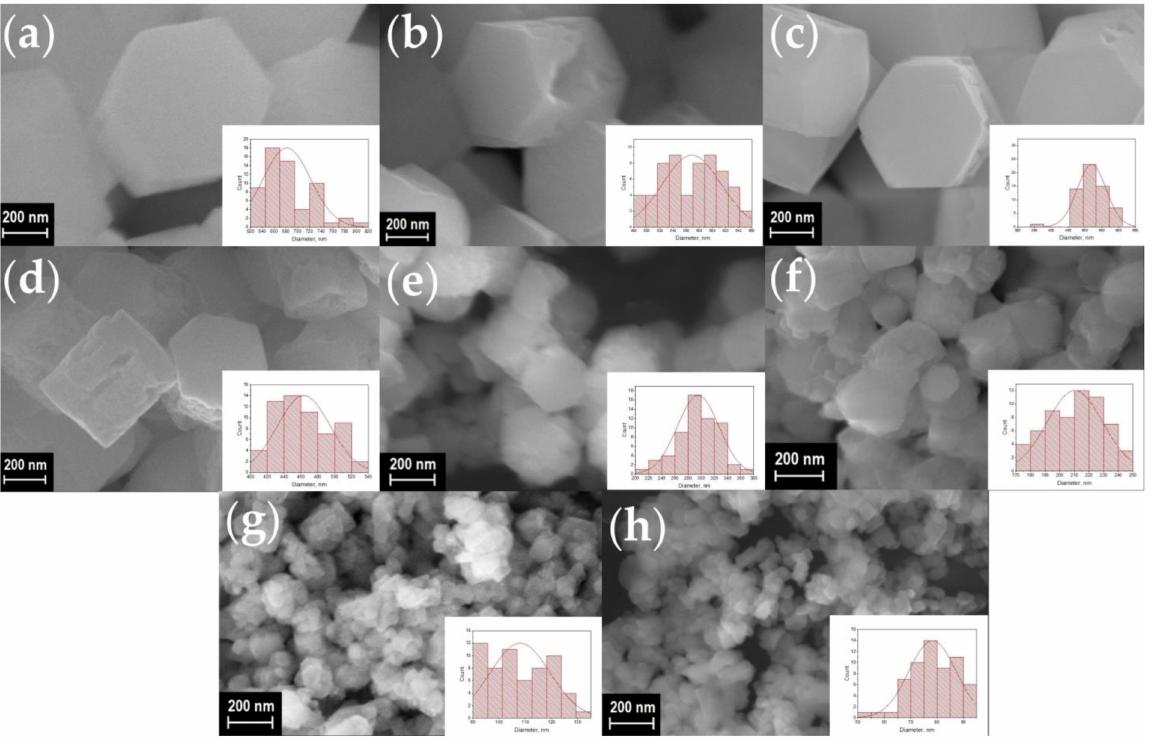
Figure 3. SEM images of the samples NaY 1 − x Sm x F 4 ( a – h ): x = 0, 2, 5, 10, 20, 30, 40, and 50 at.% of Sm 3+ . Particle size distribution of the samples is shown in the insets. The average diameter of particles is equal to about 682 ± 41, 568 ± 44, 520 ± 43, 463 ± 31, 295 ± 32, 210 ± 19, 108 ± 11, and 78 ± 9 nm for the Sm 3+ concentration of 0, 2, 5, 10, 20, 30, 40, and 50 at.%,